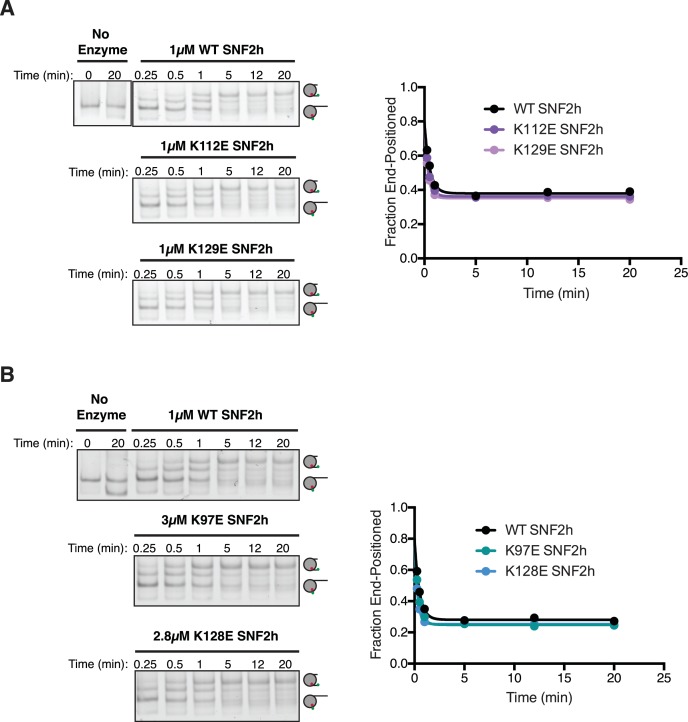
Mutations to the N-terminus have minimal effects on remodeling.(A and B) Left. Cy3-fluorscence scan of native gel remodeling assays with WT nucleosomes and either WT or mutant SNF2h. Saturating concentrations of SNF2h were used for all constructs. Right. Quantifications of the gel images shown at the left. The residues chosen are lysines in AutoN that crosslinked to the acidic patch in only the ADP•BeFx state. In all cases, the mutations showed no appreciable effect on remodeling (<2 fold difference).10.7554/eLife.35322.012Figure 2—figure supplement 1—source data 1.Values used to obtain plots.